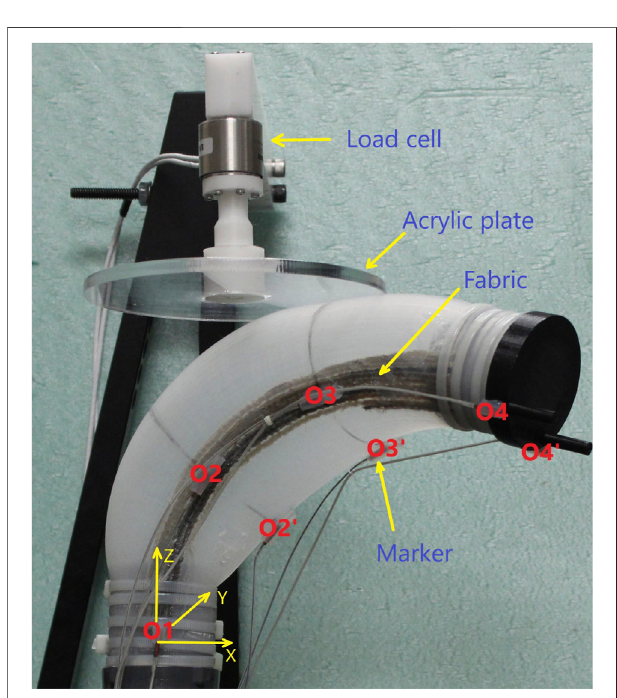
FIGURE 7 | The contact case at disc three for contact forces measurement and 7 markers for the robot poses